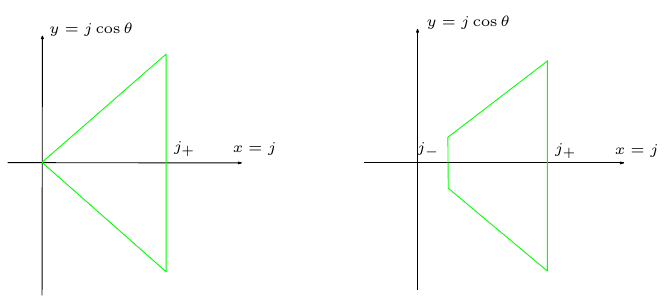
Figure 2 . The moduli space on the ( x, y ) -plane is a polytope, deliminated by the facets (they are edges too) of the polytope. The picture on the left depicts the moduli space when j one on the right applies when j 0 . We only consider the former instance. The scaling limit lies − > at point (0 , 0) . The figures are from